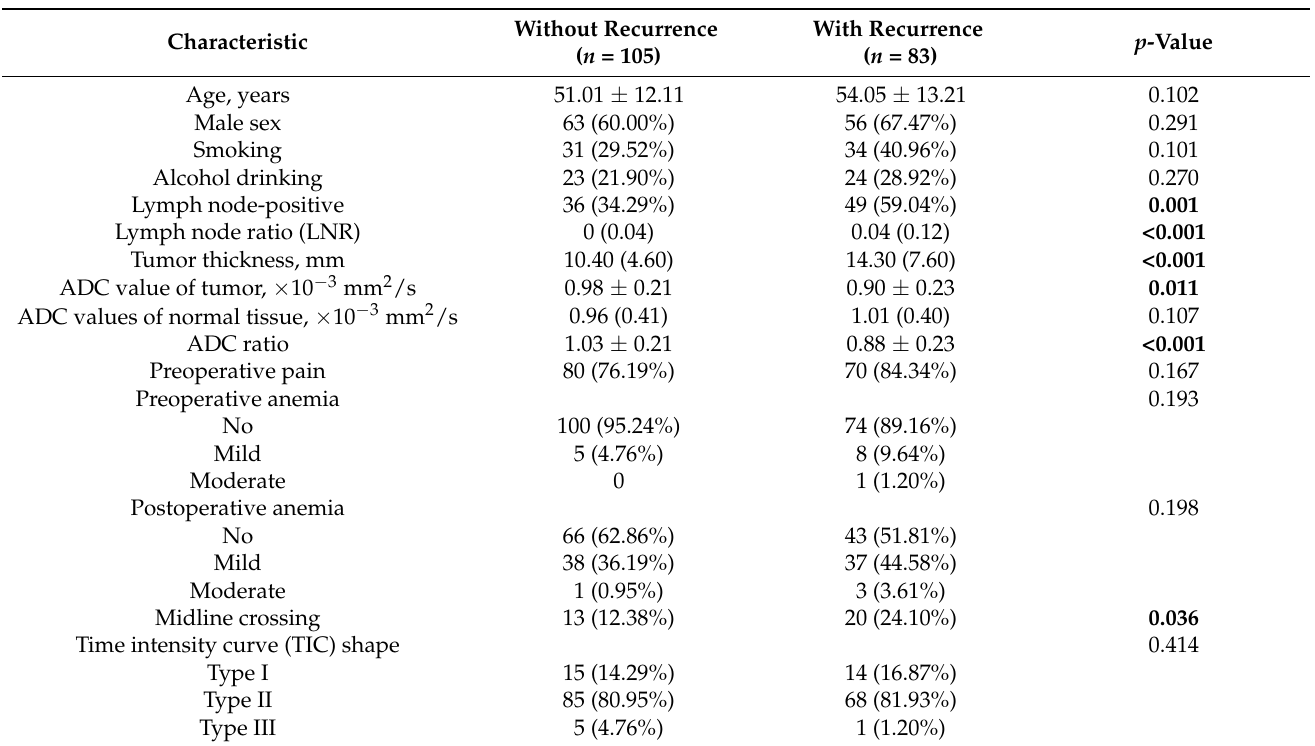
Table 1. Baseline and Treatment Characteristics of Patients (Without recurrence vs. with